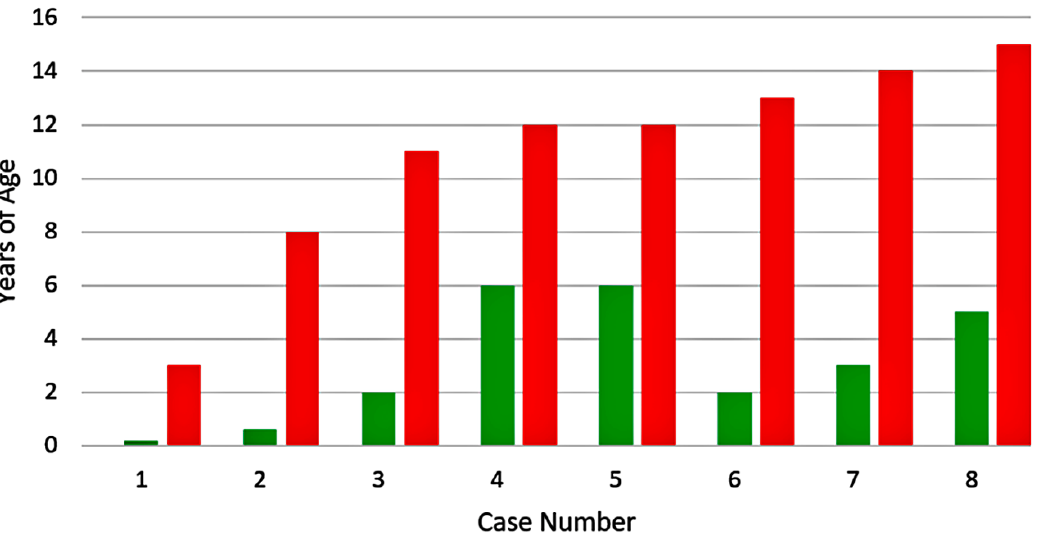
Figure 6. Eight cases of varicella meningitis caused by wild type virus. Each child had herpes zoster prior to developing meningitis. Data from references [36,37]. Age of wild type varicella: green bar; age of meningitis: red bar.